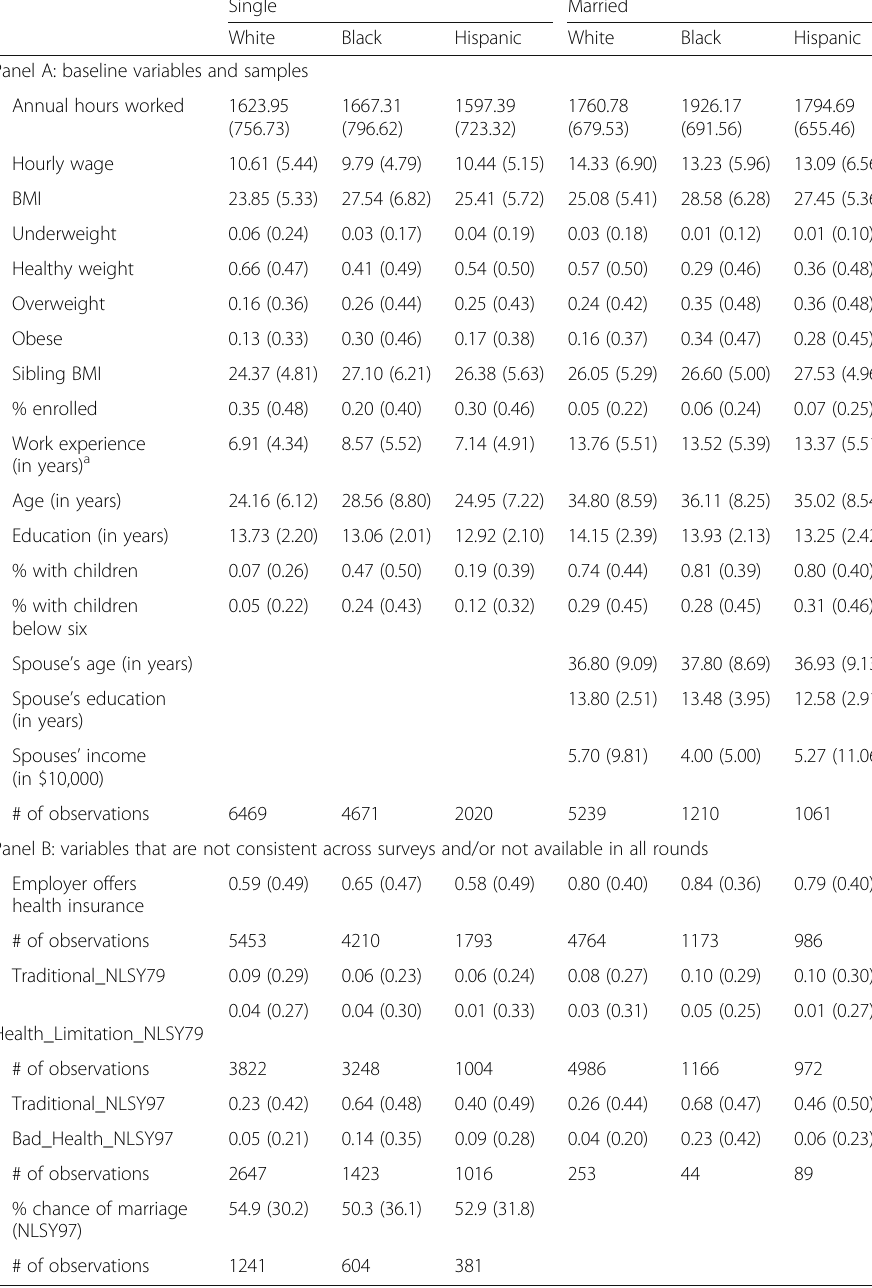
Table 1 Summary statistics for